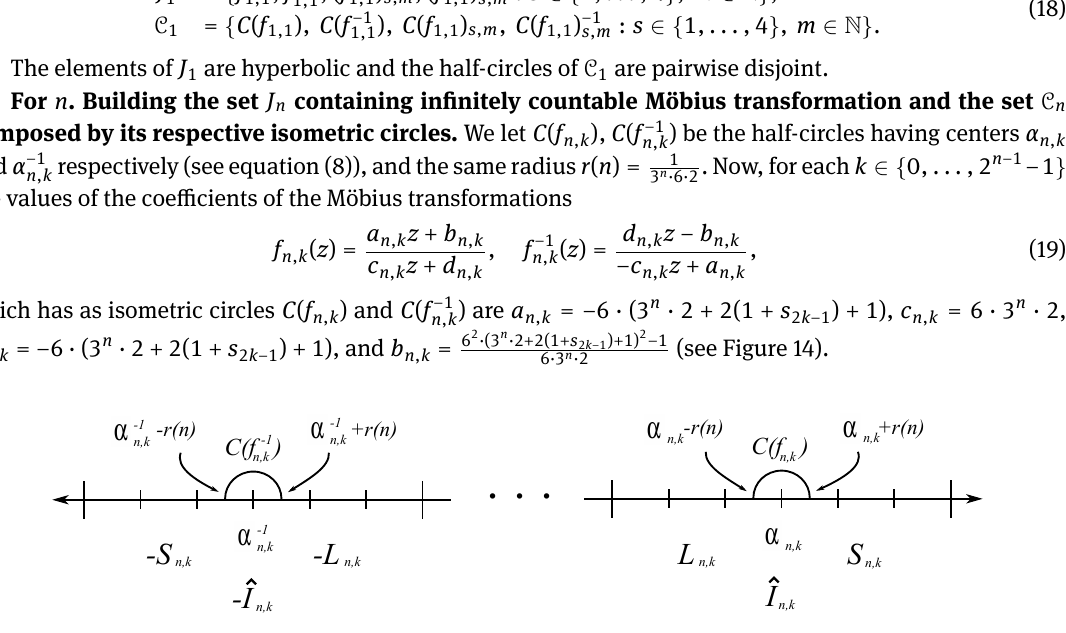
Figure 14: The closed intervals ˆ I n , k and −ˆ I n , k are divided into six closed